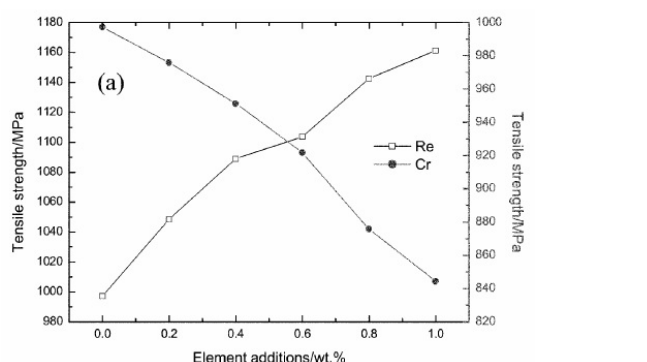
Figure 1. Variation in ( a ) tensile strength and ( b ) elongation with Re addition [50]. Reproduced with permission from Liu et al, Bulletin of Materials Science; published by Springer, 2008.